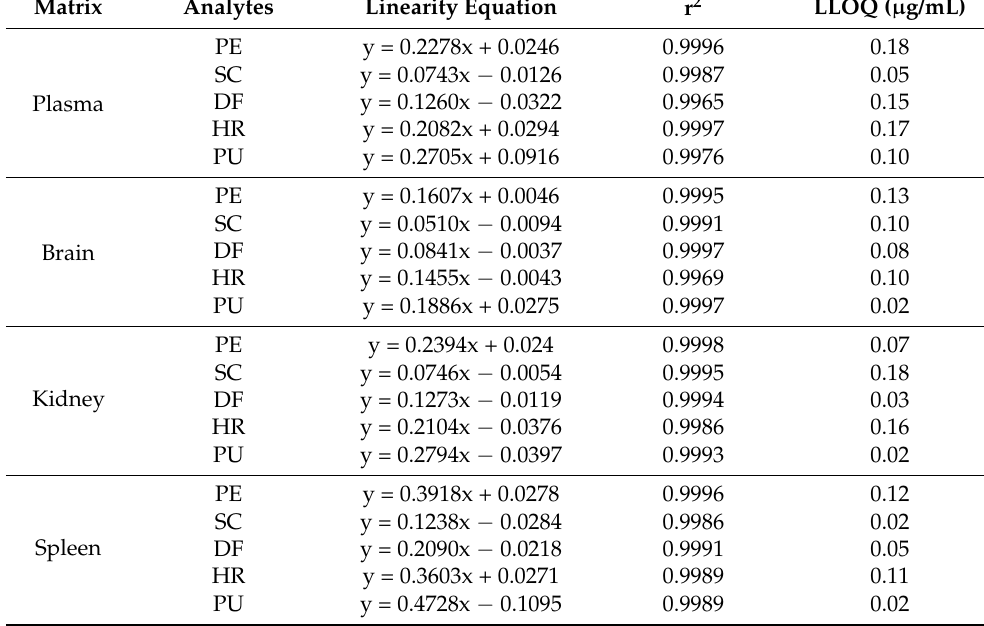
Table 1. Linearity equations of calibration curves and LLOQ determined for coumarins in plasma and tissue matrices.